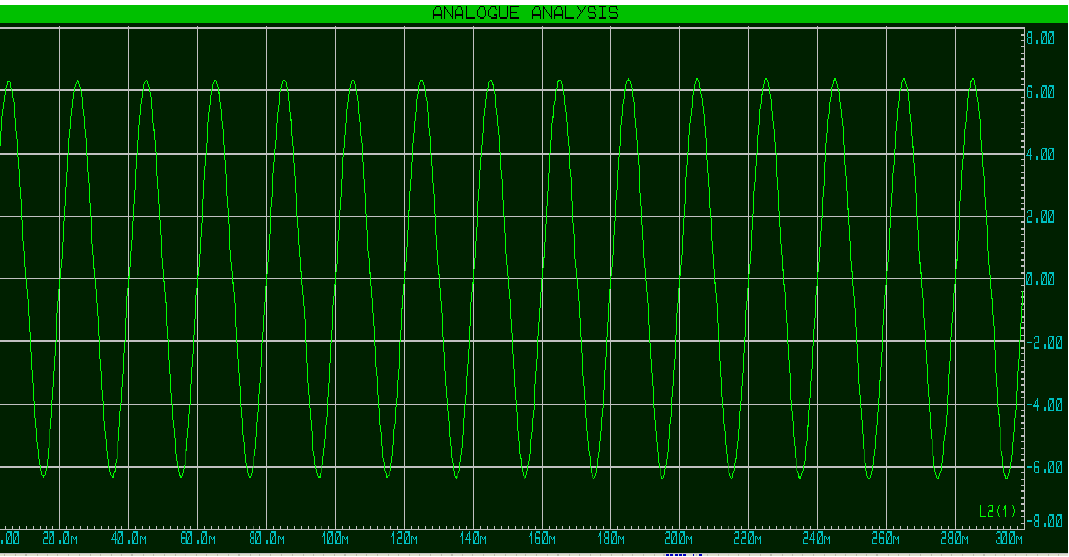
Figure 17. Current waveform after compensating by SAPF.